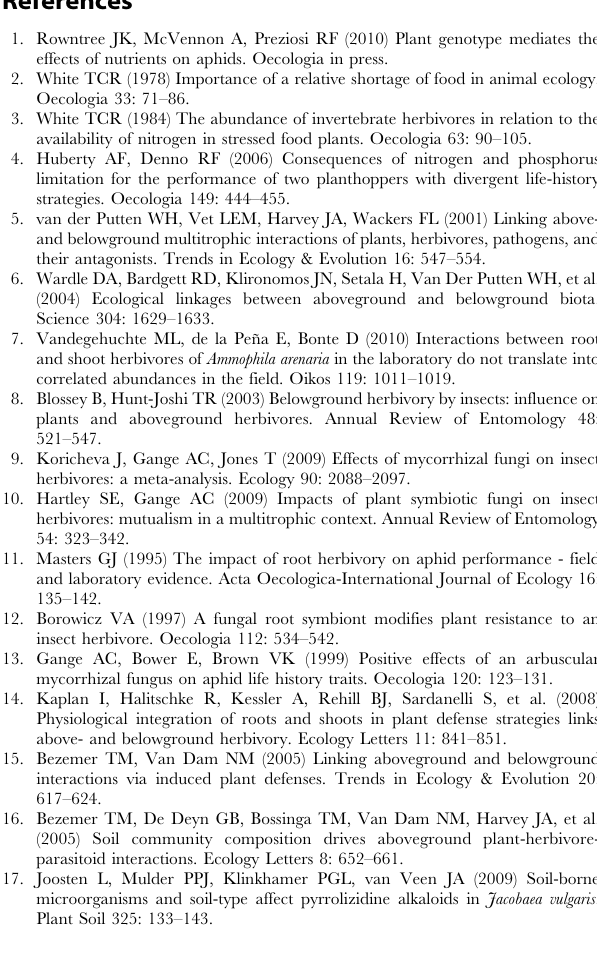
Figure S3 Differences in plant available P of treatment soils according to region, abiotic soil component and unsterile soil inoculum (mean + SE). Significant pairwise differences are indicated by different letters above the bars (P , 0.05). Region - PE: Le Perroquet, WE: Westhoek, TY: Ter Yde. Soil - D: sterile soil component of dynamic dune, S: sterile soil component of biota, s: stabilised dune